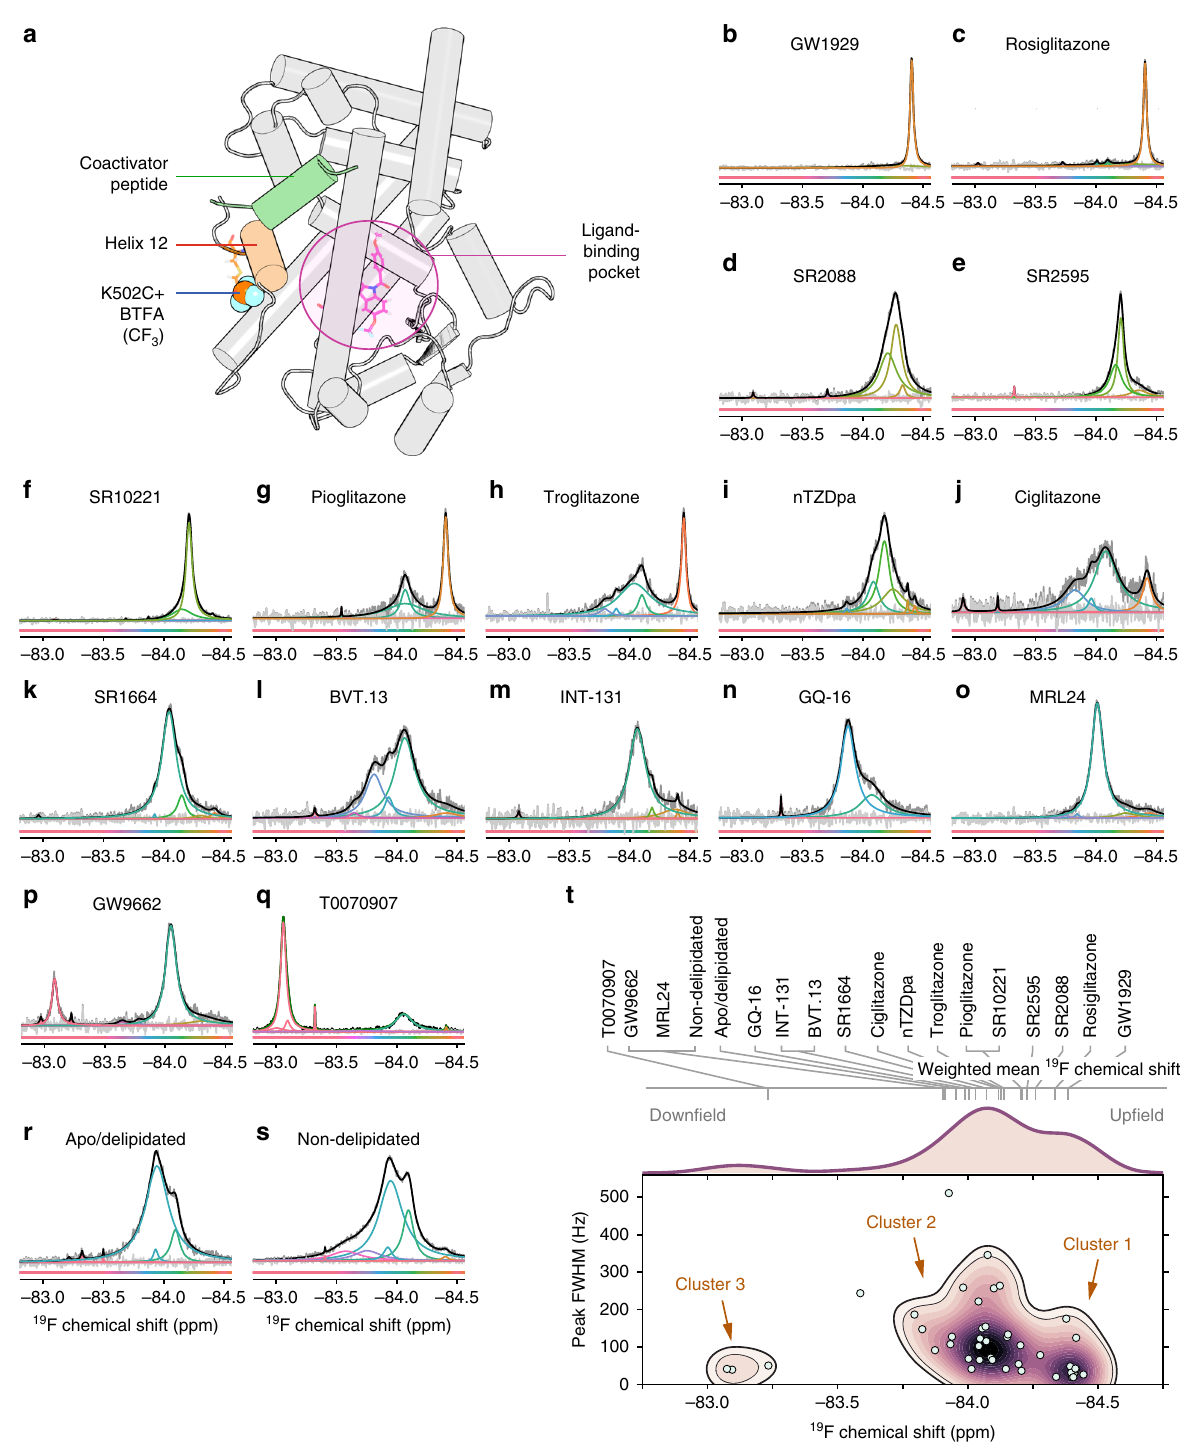
Fig. 2 19 F NMR analysis of PPAR γ K502C -BTFA bound to 16 pharmacologically distinct ligands. a Location of covalently attached BTFA tag. b – s 19 F NMR spectra (medium gray lines) of PPAR γ K502C -BTFA b – q bound to ligand and ordered according to mean-weighted 19 F chemical shift or r delipidated and s non-delipidated apoprotein. Fitted peaks are colored according to fi tted 19 F chemical shifts; deconvoluted spectra and residuals are shown in black and light gray lines, respectively. Some of these spectra have been replicated (Supplementary Fig. 10). t Plot of the full width half max (FWHM) of the major fi tted peaks (only peaks that comprise >5% of the spectrum area are included) vs. fi tted chemical shifts. Clusters were detected by bivariate kernel density estimation (purple contours) with mean-weighted 19 F chemical shift values annotated on top of the plot. Computational simulations were run of labeled PPAR γ (PPAR γ K502C -BTFA) bound to one of these 16 ligands (GW1929) that demonstrate that the tag stays on or near the surface of the